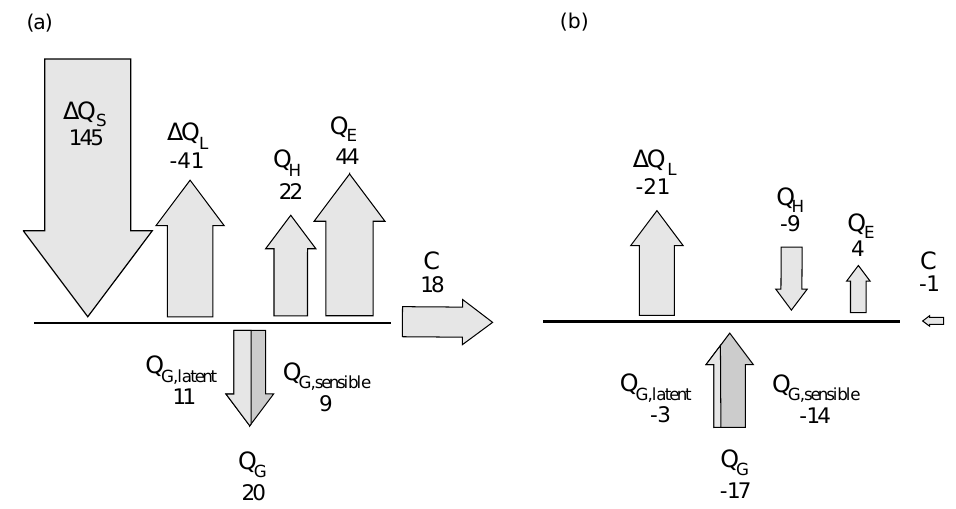
Fig. 9. The partitioning of the surface energy balance during (a) the summer period from 7 June 2008 to 30 August 2008 (cf. Langer et al., 2011) and (b) the winter period from 1 December 2007 to 30 January 2008 (Table 2). The areas of the arrows are scaled according to the heat flux values. The ground heat flux at the tundra site Q G is separated according to the internal energy storage into sensible Q G , sensible and latent heat Q G , latent